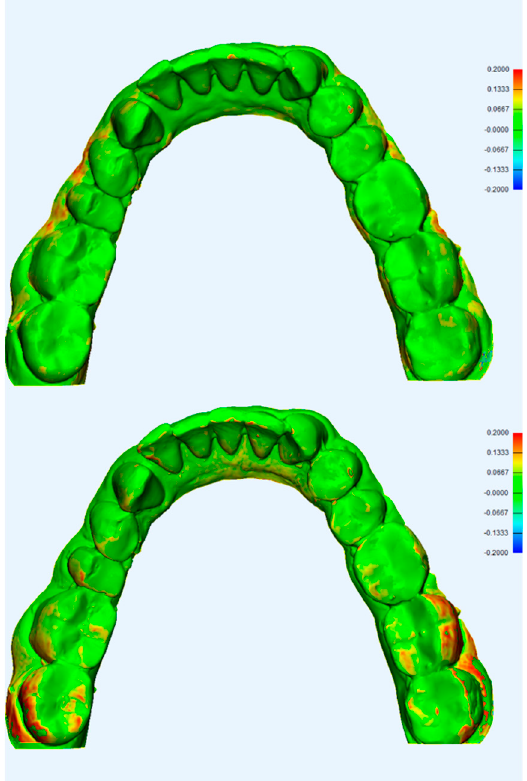
deviation values noted at the incisal/occlusal anatomy of the teeth and the posterior region, as seen in Figure 7.